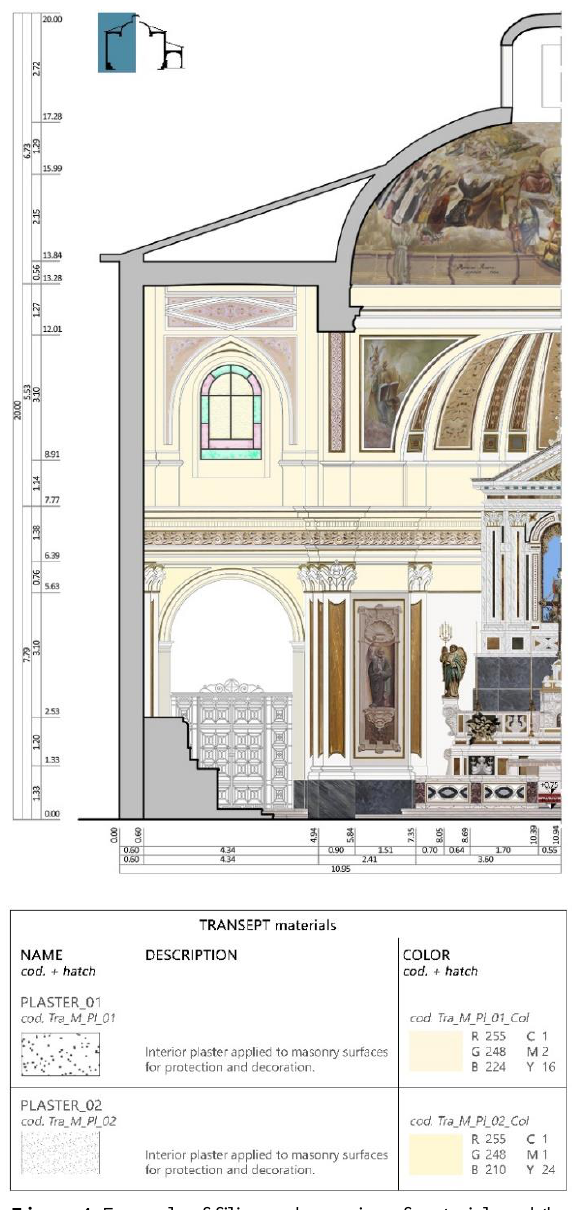
Figure 4 . Example of filing and mapping of materials and their colours in relation to the architectural space, segmented and annotated with the semantic concept of